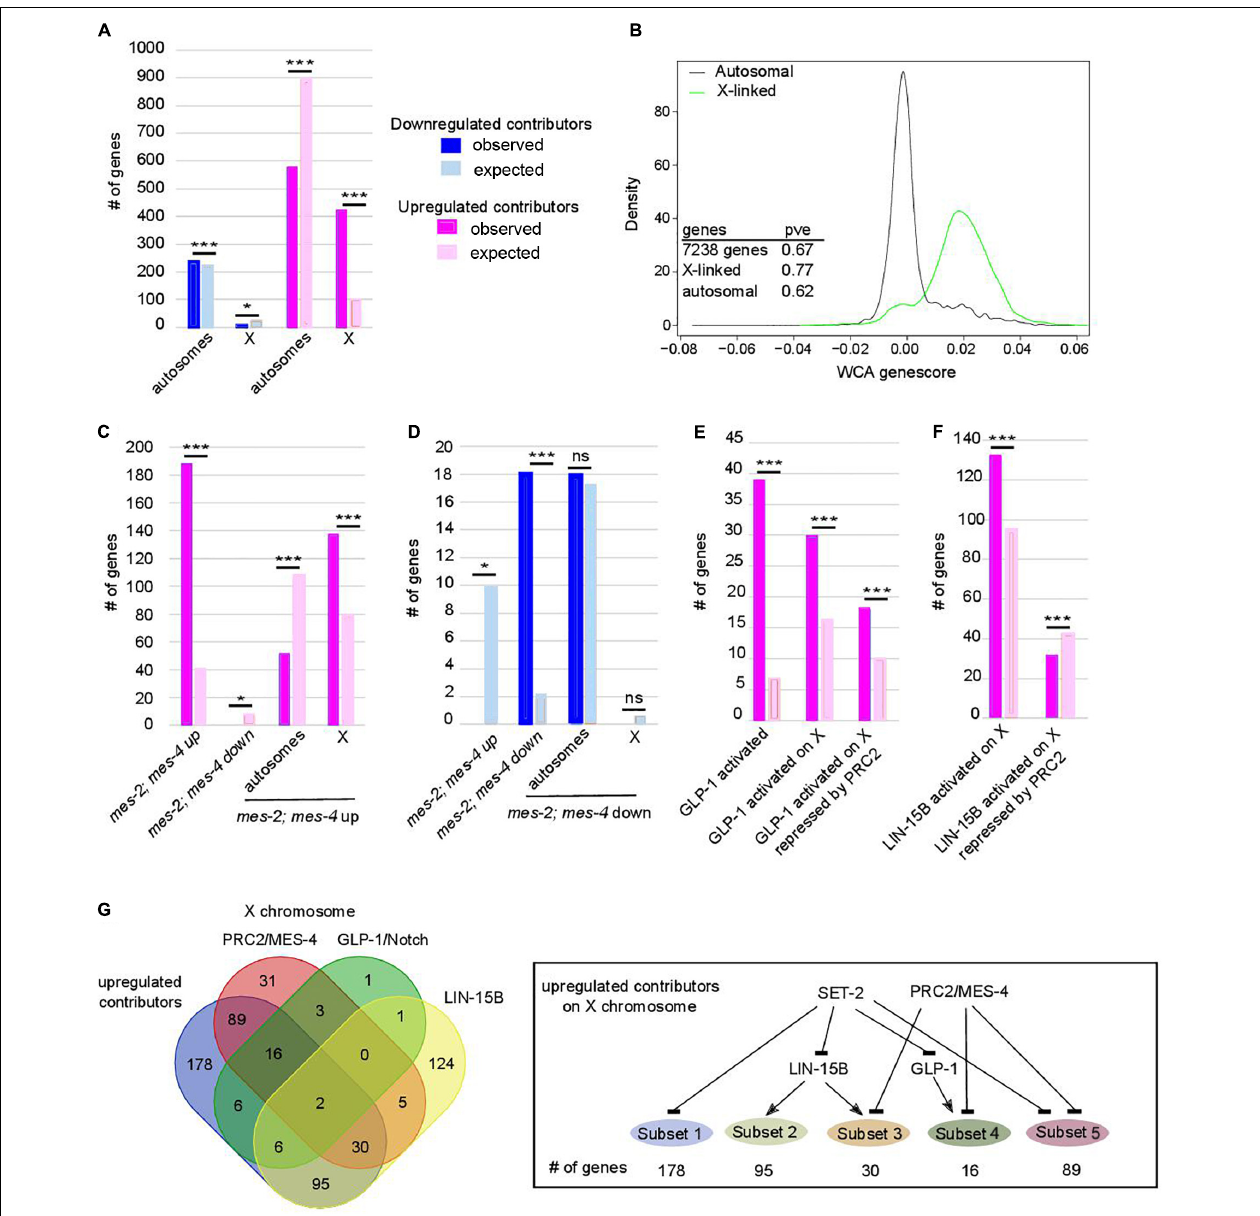
FIGURE 3 | Chromosome X desilencing is a priming event for loss of germline identity. In (A,C–F) * p -value < 0.05 and *** p -value < 0.001 calculated by hypergeometric test. Color code in bar graphs is the same throughout. (A) Chromosome distribution of contributors. p = 4.4e-5 and 6.1e-193 for distribution of down- and upregulated contributors, respectively. (B) Distribution of WCA score according to location of the genes on autosomes or the X chromosome (pve = percent of variance explained by PC1 when within-class PCA is run on the indicated set of genes only). (C) Comparison of upregulated contributors with mes-2 ; mes-4 up- and downregulated genes and chromosome distribution of upregulated class. p = 2.34e-97 for over-enrichment in mes-2 ; mes-4 upregulated genes, p = 3.6e-4 for under-enrichment in mes-2 ; mes-4 downregulated genes, p = 3.2e-21 for chromosome distribution. (D) Comparison of downregulated contributors with mes-2 ; mes-4 up- and down-regulated genes and chromosome distribution of downregulated class. p = 3.9e-5 for under-enrichment in mes-2 ; mes-4 upregulated genes, p = 5.84e-14 for over-enrichment in mes-2 ; mes-4 downregulated genes, p = 0.5 for chromosome distribution. (E) Comparison of upregulated contributors with genes activated by GLP-1. p = 1.25e-24 for over-enrichment in GLP-1 activated genes, p = 7e-6 for over-enrichment in X-linked GLP-1 activated genes, p = 1e-2 for over-enrichment in X-linked GLP-1 activated genes repressed by PRC2/MES-4. (F) Comparison of upregulated contributors with genes activated by LIN-15B. Color code is the same as in (A) . p = 7.7e-9 for over-enrichment in X-linked LIN-15B-activated genes, p = 8e-3 for over-enrichment in X-linked LIN-15B-activated genes repressed by PRC2/MES-4. (G) Comparison of X-linked upregulated contributors with genes repressed by PRC2/MES-4 and genes activated by GLP-1/NOTCH or LIN-15B. Summary of connections between the regulatory networks that regulate various classes of X-linked genes in set-2 mutant germlines.